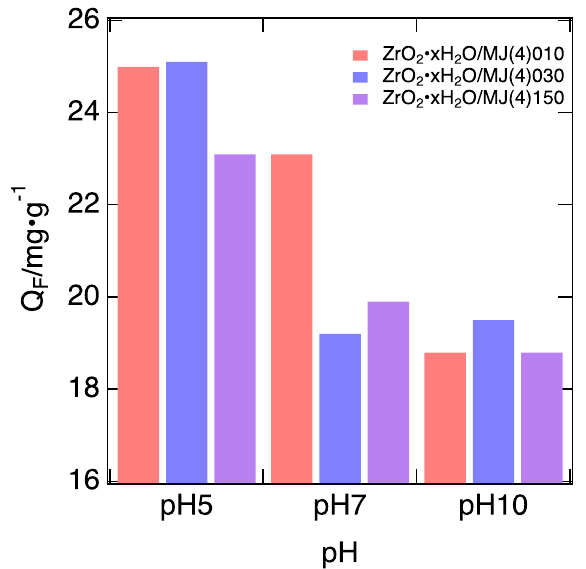
Figure 5. F − uptake measured under different pH (5, 7, and 10).